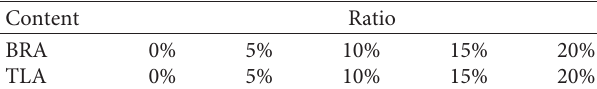
Table 7: Test scheme of natural asphalt.